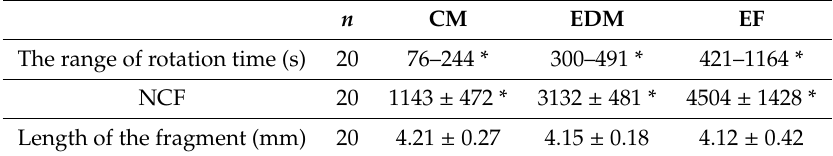
Table 3. The range of rotation time, mean ± standard deviation of the number of cycles to fracture (NCF) and length of fractured fragment between three thermally-treated NiTi file systems. n CM EDM EF The range of rotation time (s)